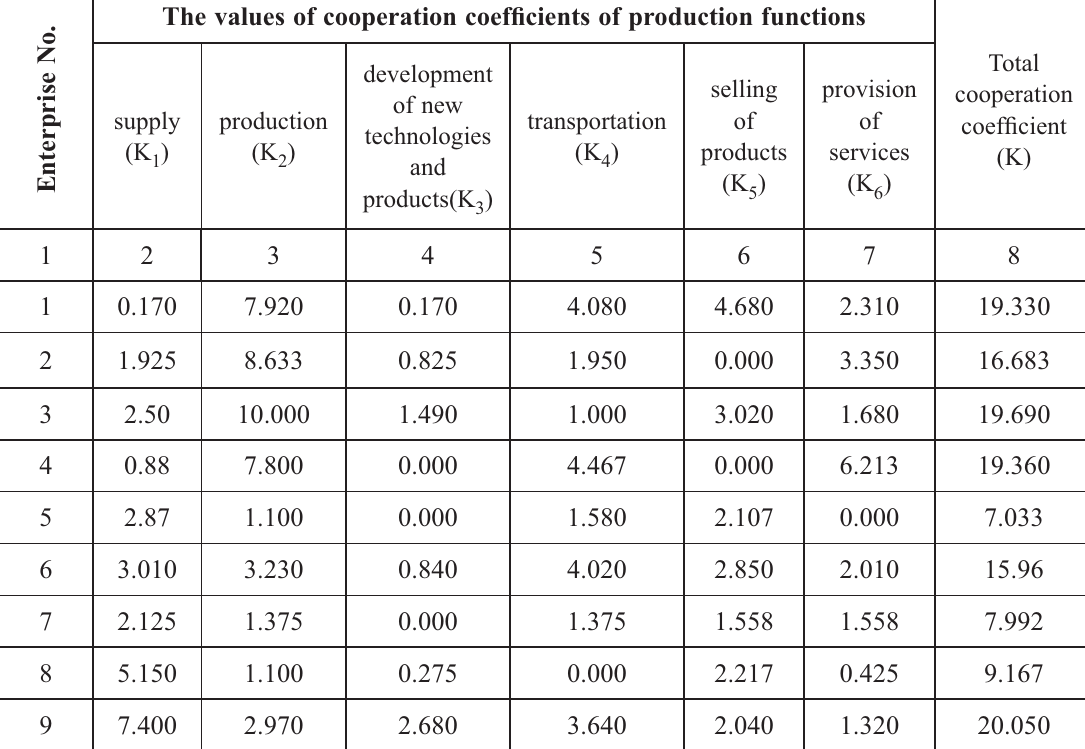
Table 3. The results obtained in calculating the total cooperation coefficient and cooperation coefficients of production functions of